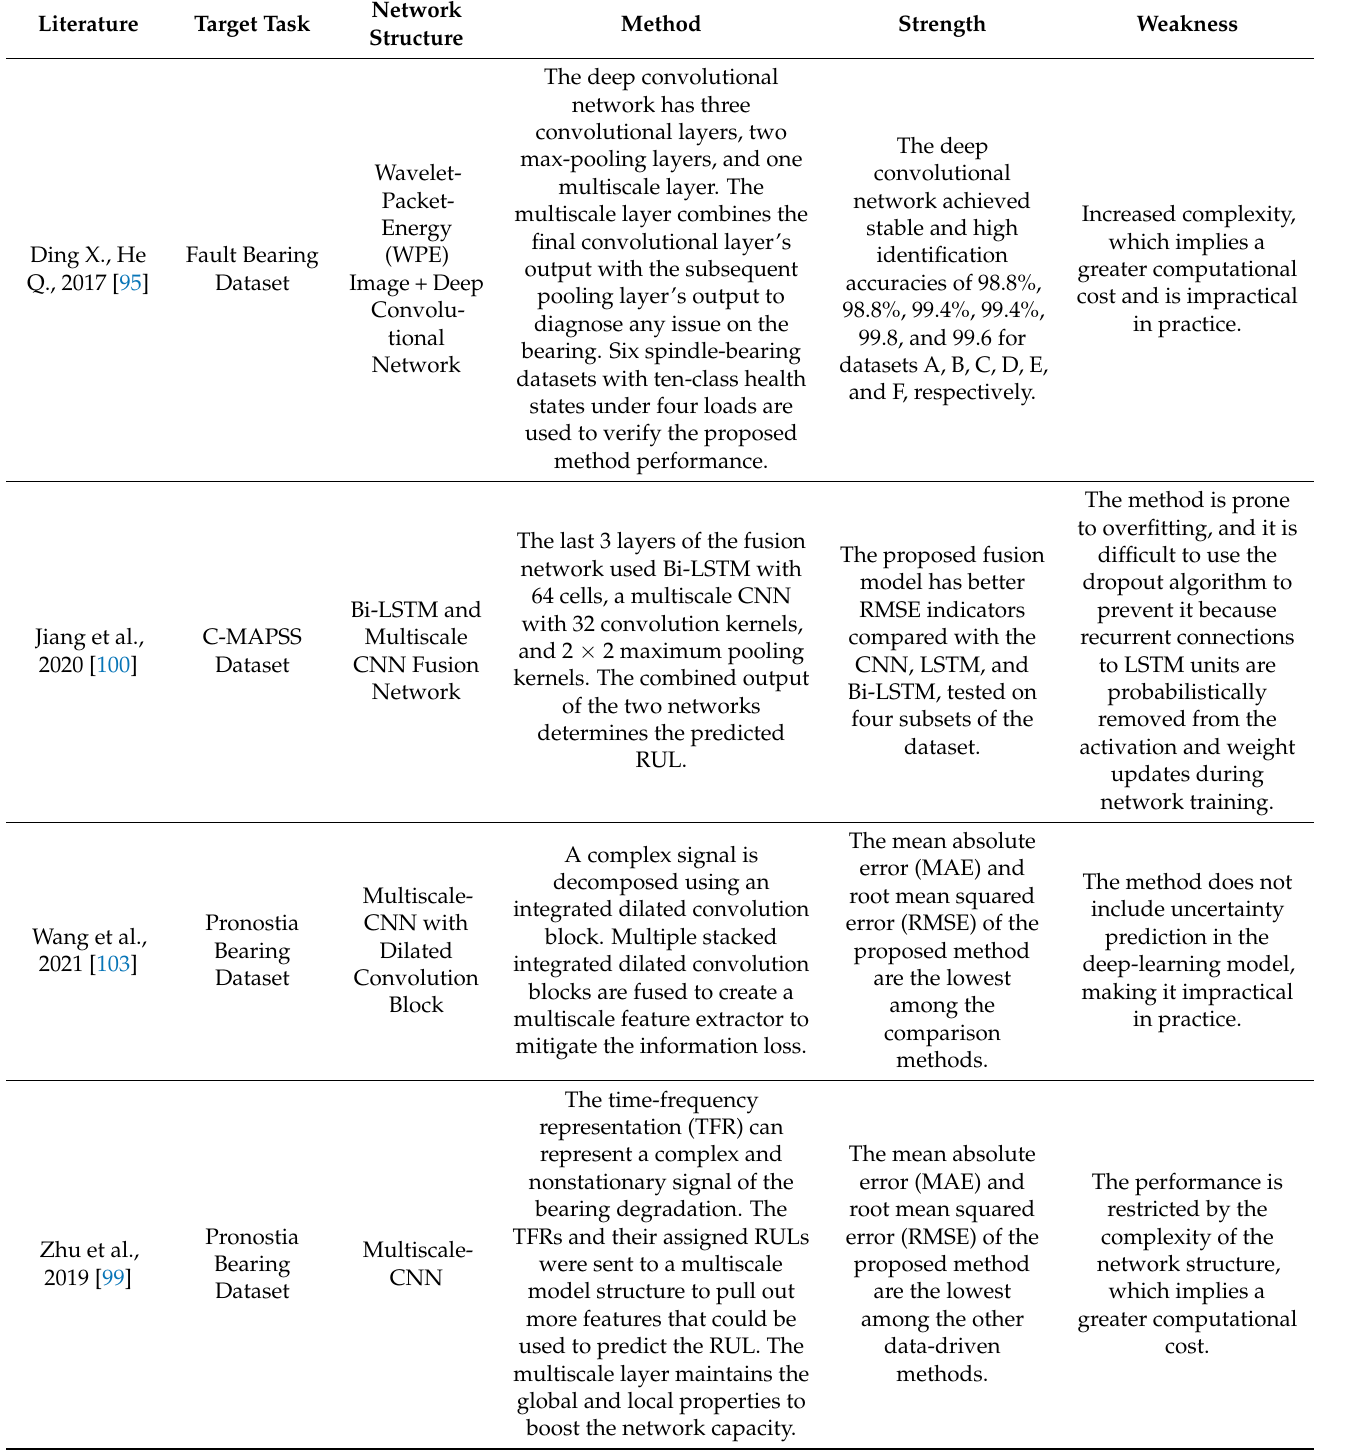
Table 4. The Application of Multiscale Deep Learning in Industrial and Manufacturing